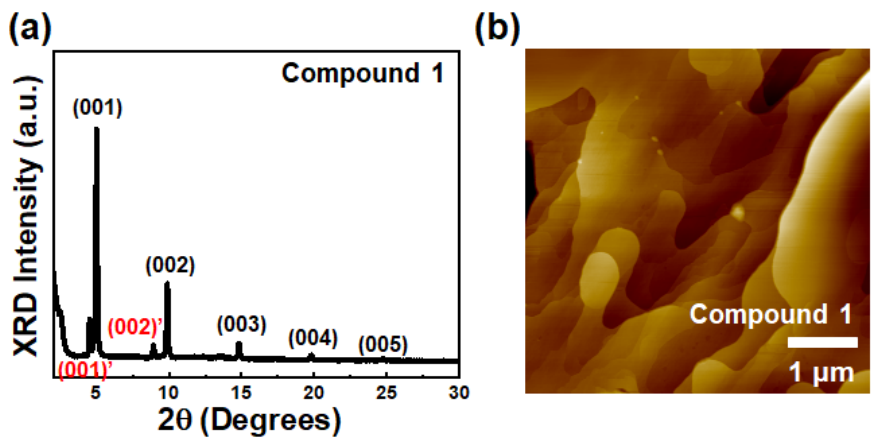
Figure 3. ( a ) XRD graph and ( b ) AFM topographic image of solution-sheared fi lm of Compound